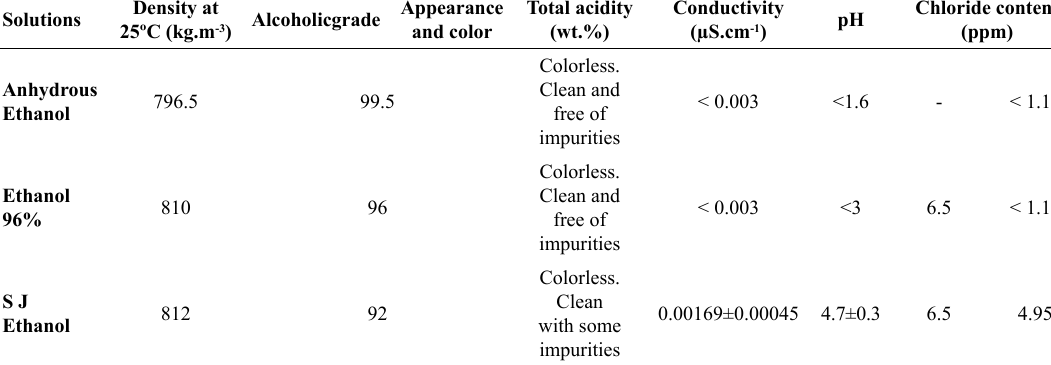
Table 1. Characteristics of the three ethanolic solutions evaluated. Density at Solutions Alcoholicgrade 25ºC (kg.m -3 )